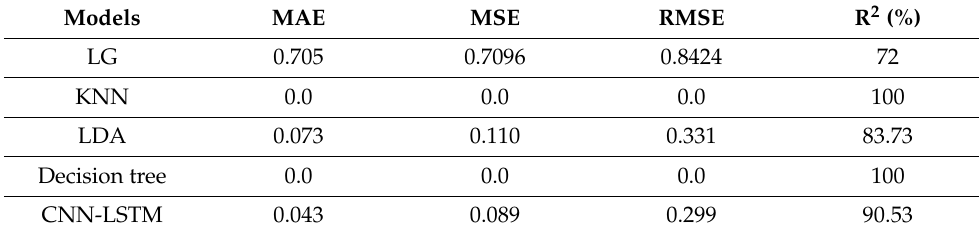
Table 14. Sensitivity analysis of ML and DL using multiclass